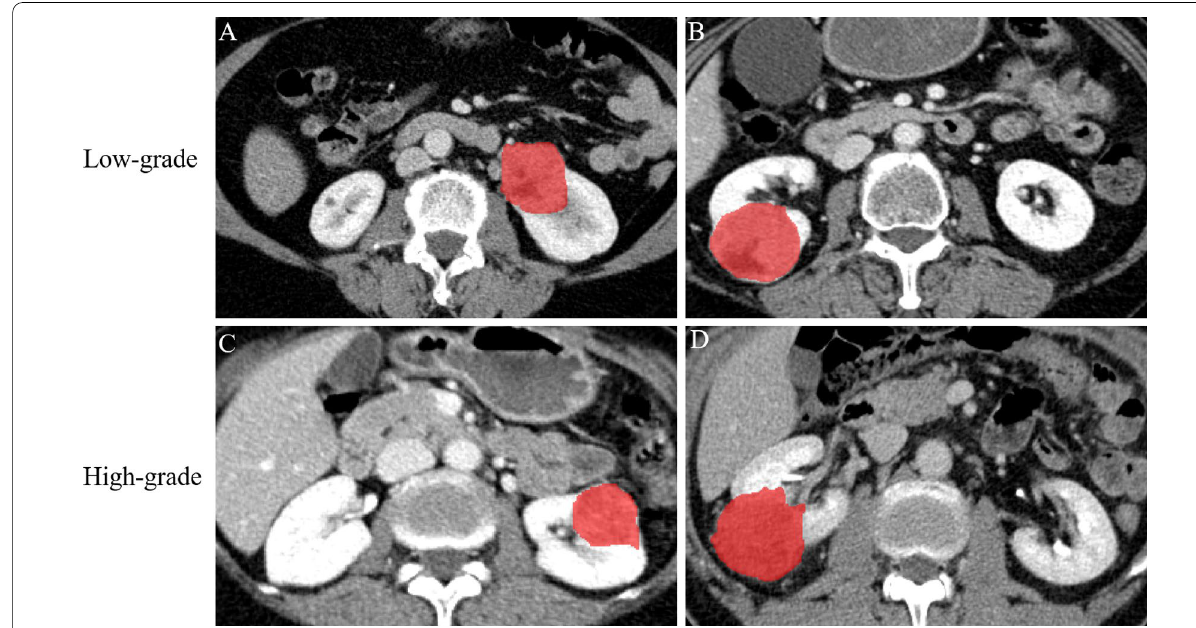
Fig. 2 Examples of manually delineated regions of interest (ROIs) on NP images. a, b The delineation of ROI on two patients with low-grade CCRCC. c, d The delineation of ROI on two patients with high-grade